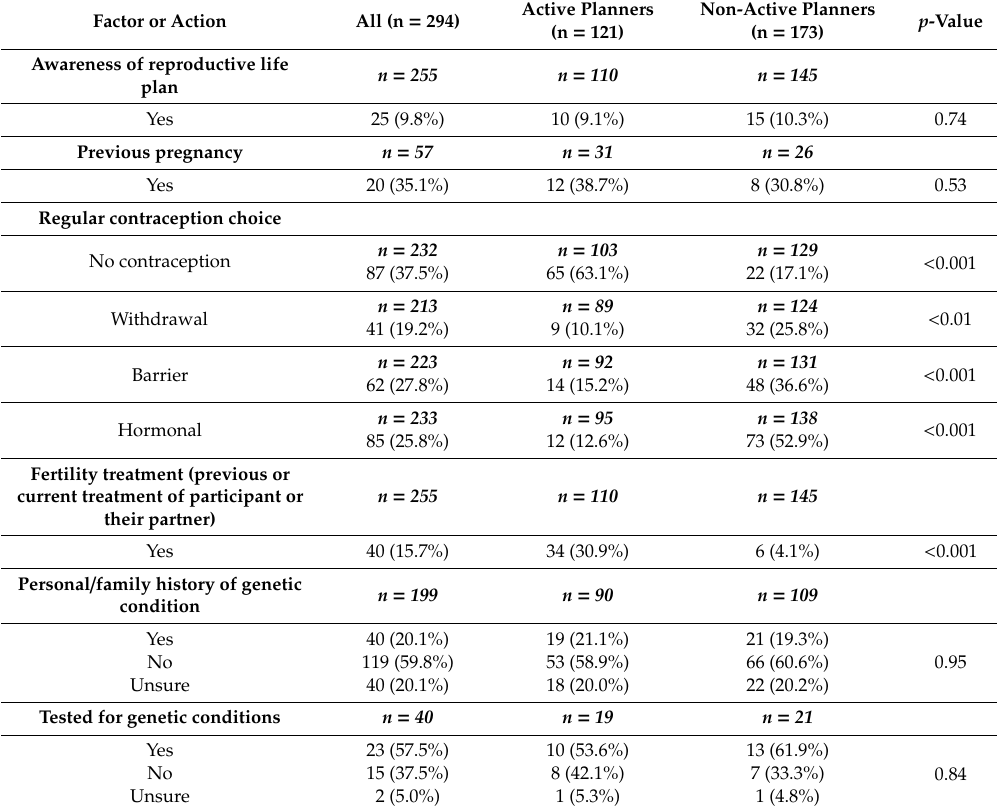
Table 2. Reproductive health, actions and awareness, stratified by pregnancy